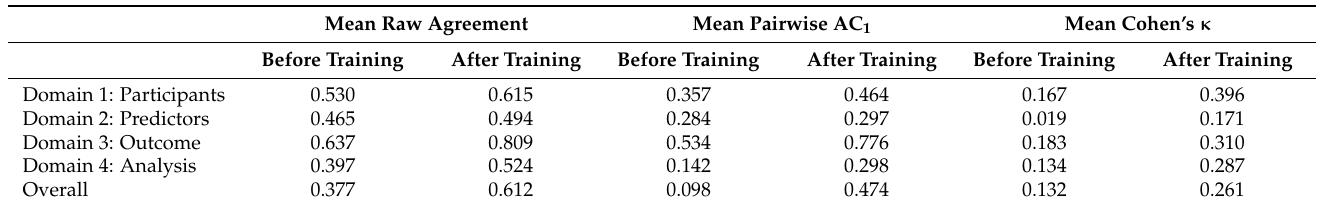
Table 2. Mean pairwise raw agreement, mean pairwise AC 1 and mean Cohen’s κ before and after training for the domain-specific and overall ROB